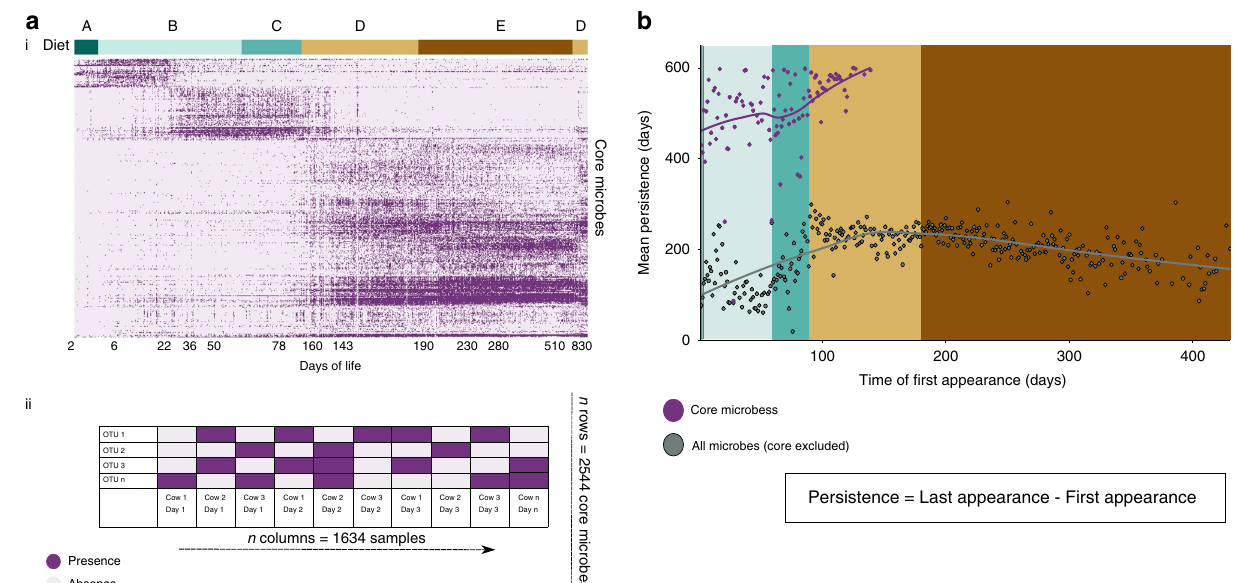
Fig. 3 The core successional microbiome persists throughout rumen microbiome development, showing age-dependent shifts. a (i) Heat map showing core successional microbes ( n = 2544) subjected to hierarchical clustering. Diets are indicated in the color-coded bar above. (ii) Graphical illustration explaining the heat map structure. Each row represents a core OTU and each column represents an animal sampled at a speci fi c time. b Early-appearing and persistent core successional microbes. Core successional species persistence ( Y -axis) as a function of time of appearance ( X -axis). Each dot represents the average persistence (number of days) of all microbes that arrived in the ecosystem on the speci fi ed day. Species appearance was measured over a 600-day window from fi rst appearance, and persistence was calculated as the mean of the Δ ( t fi rst appearance − t last appearance ). Purple dots represent core successional microbes, gray dots represent non-core Microbes. Source data is provided as a Source Data fi